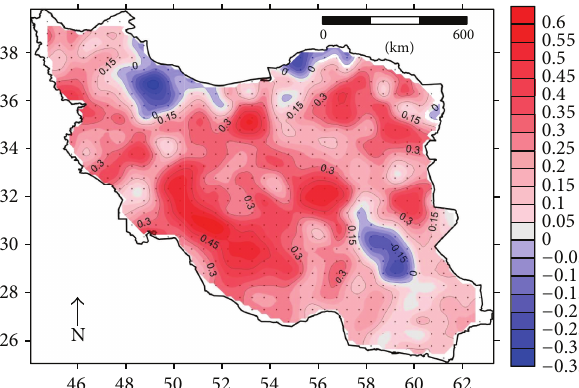
Figure 6: Pearson product-moment correlation coefficients for the relationship between “year” and the number of days with precipitation ≥ 10